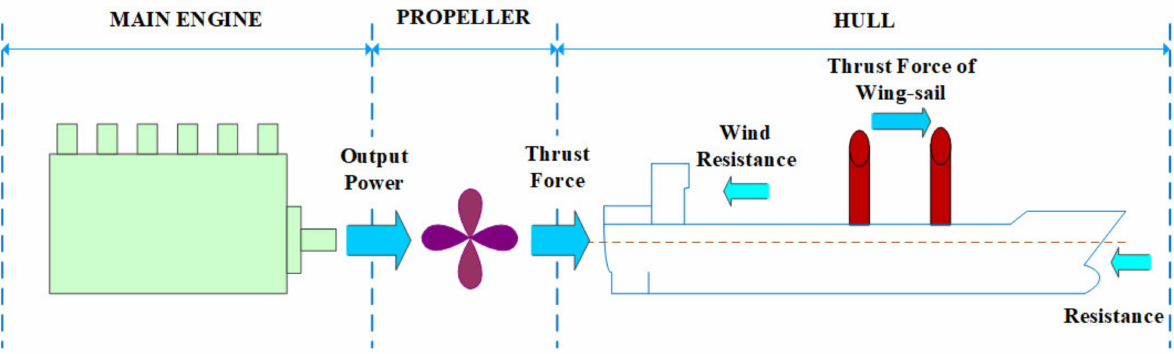
Figure 1. Force analysis diagram of wing sail-assisted